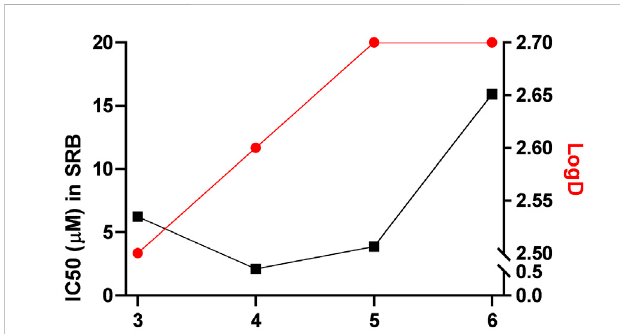
FIGURE 4 Correlation between the logD and the IC 50 values in alkanoyl- protected complexes. The black line represents the IC 50 values, while the red line represents the logD values.